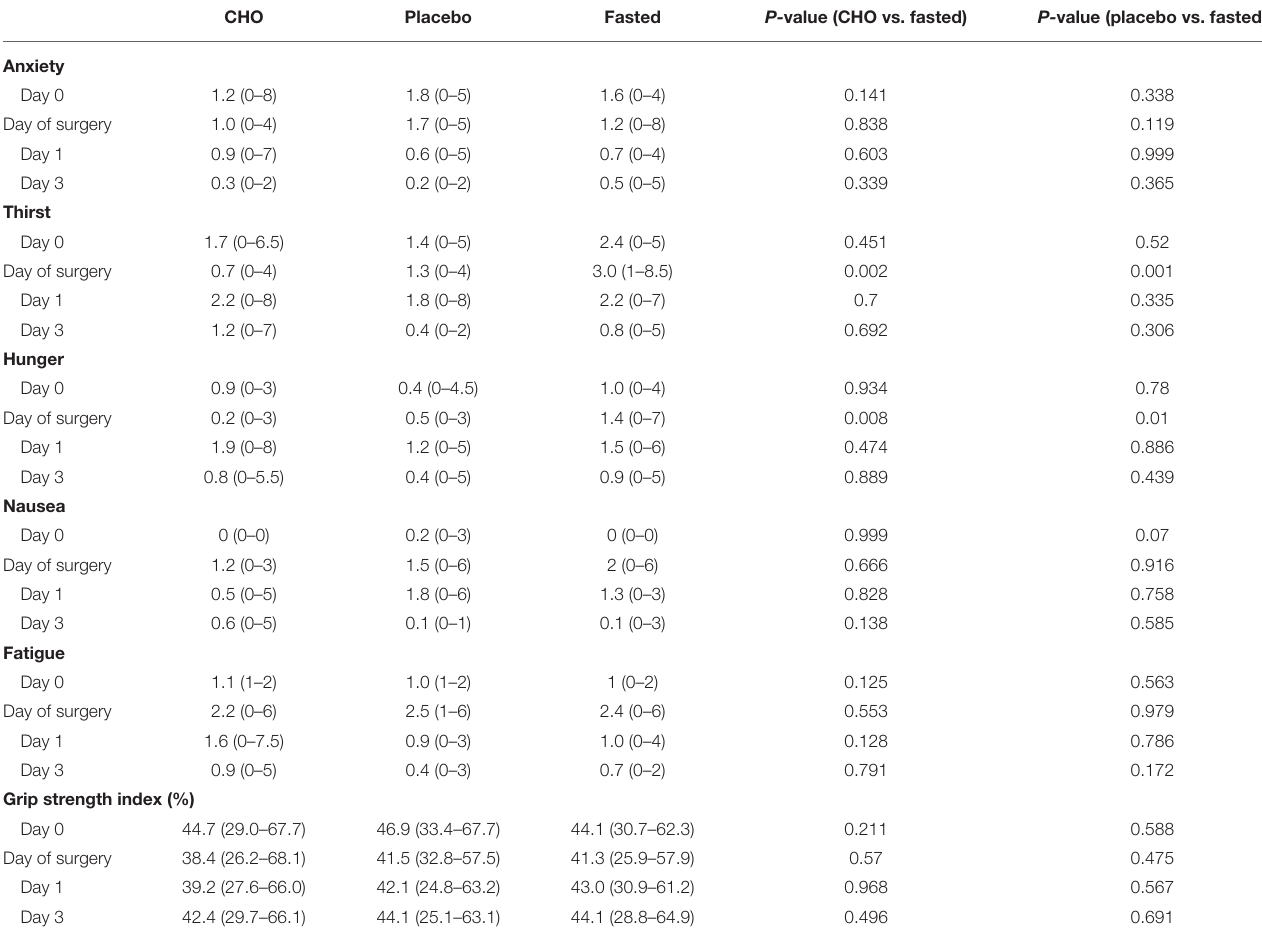
TABLE 3 | Comparison among subjective comfort in the three groups. CHO Placebo Fasted P- value (CHO vs. fasted) P- value (placebo vs. fasted)